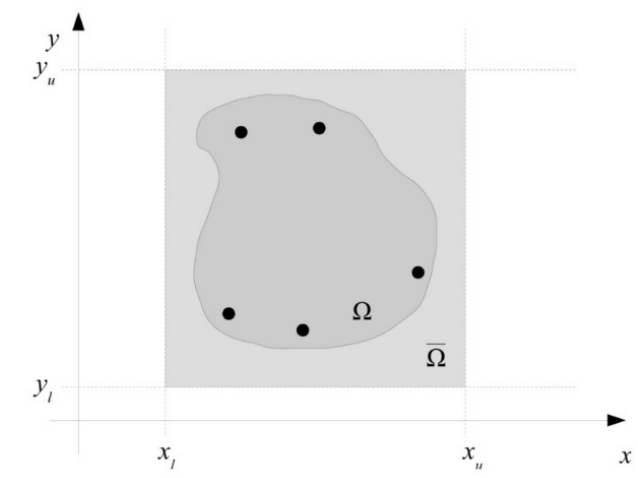
Figure 4. Cross section Ω and integration domain Ω